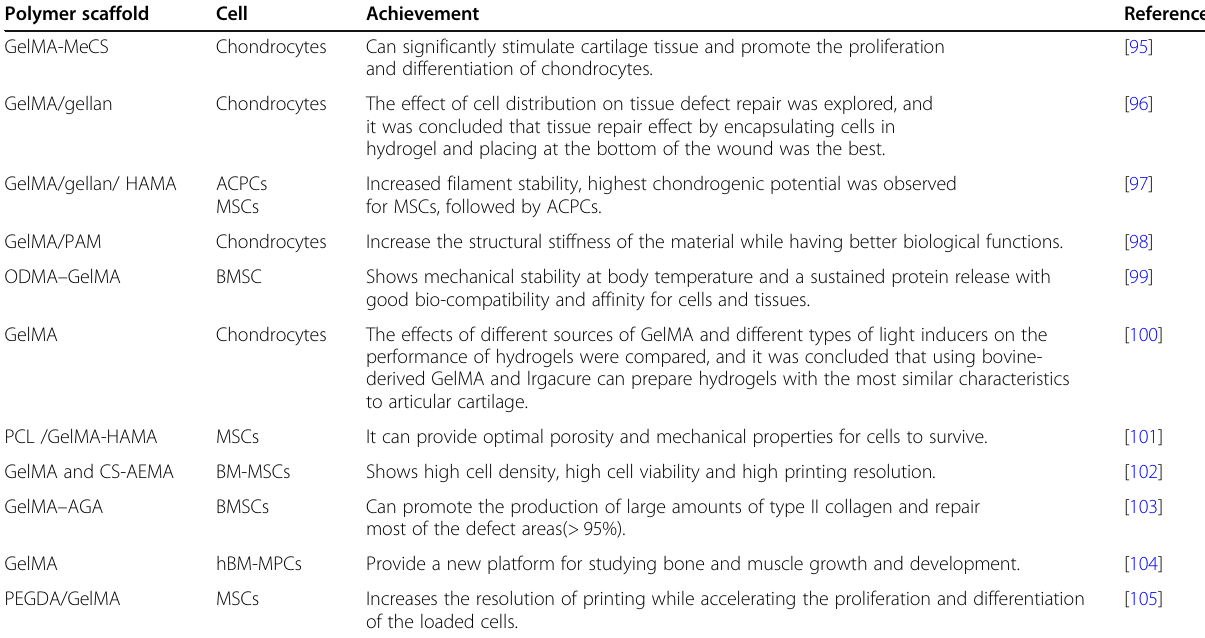
Table 4 The recent application of GelMA in cartilage engineering Polymer scaffold